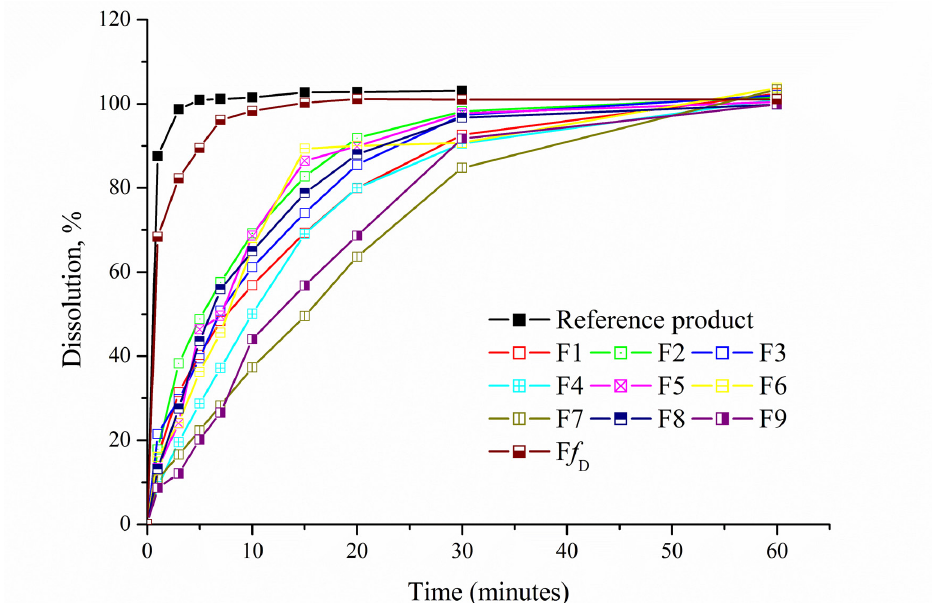
FIGURE 6 - Dissolution profiles of orodispersible films (F1-9) and the reference product (Cardura™ 2 mg tablets; Pfizer Inc.,